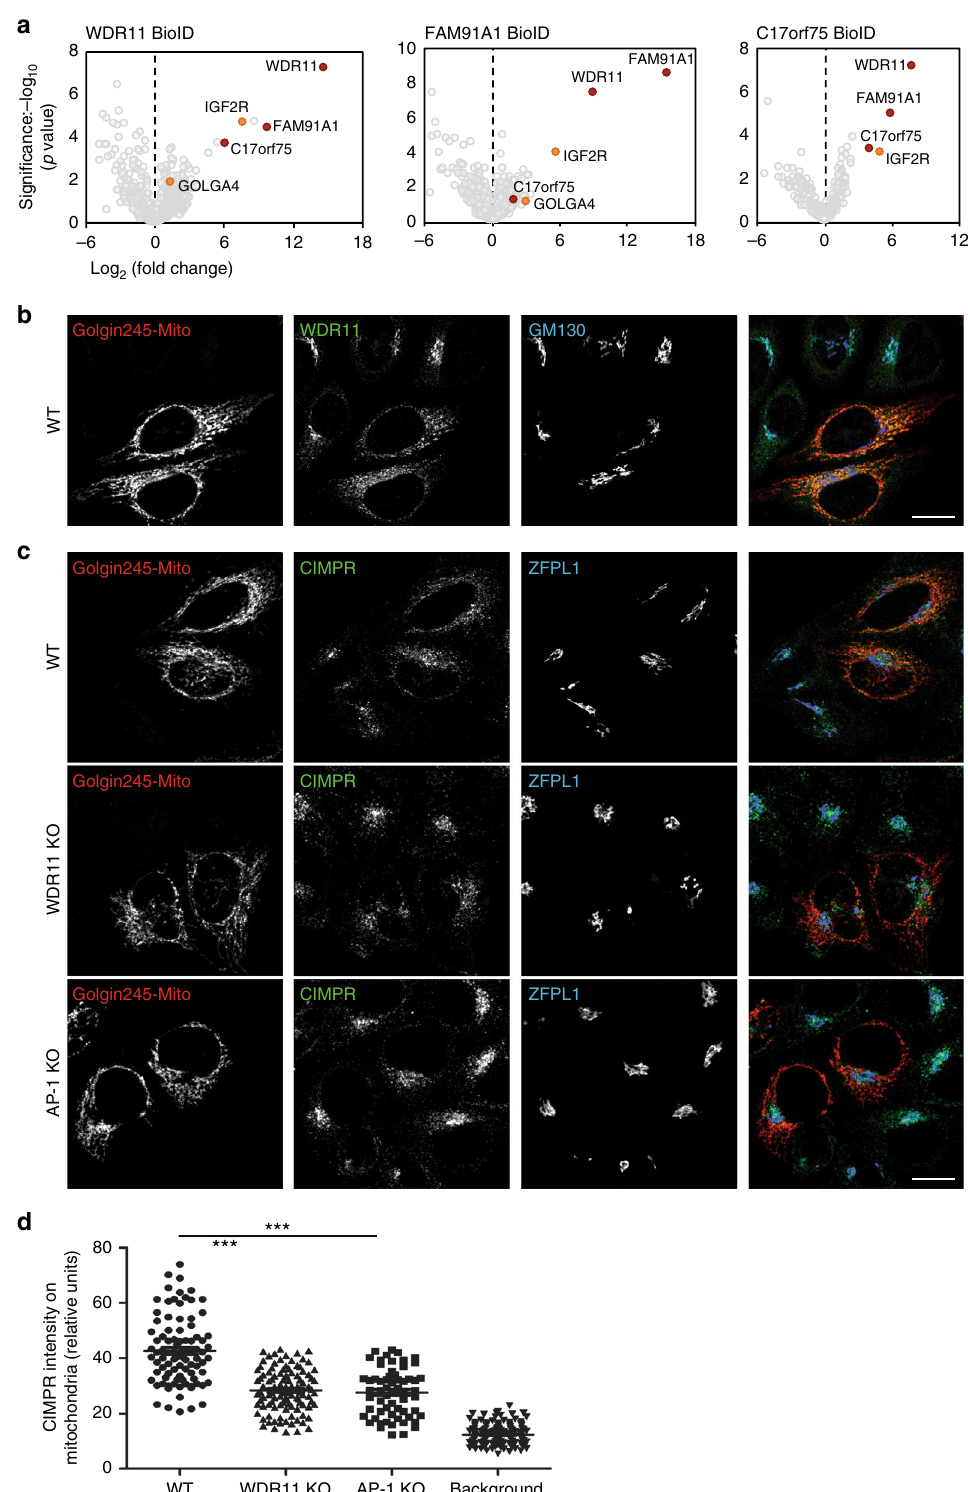
Fig. 6 Identi fi cation of additional interacting proteins by BioID. a BirA* was attached to WDR11, FAM91A1 or C17orf75, and biotinylated proteins were captured with streptavidin. Proteins predicted to be bona fi de binding partners are indicated on the volcano plots. IGF2R = CIMPR; GOLGA4 = golgin-245. b Golgin-245 was ectopically localised to the mitochondrial outer membrane (golgin-245-mito) and cells were triple labelled for WDR11 and the Golgi protein GM130. Expression of golgin-245-mito causes WDR11 to relocate to mitochondria. c Golgin-245 was ectopically localised to the mitochondrial outer membrane (golgin-245-mito) and cells were triple labelled for CIMPR and the Golgi protein ZFPL1. The ability of golgin-245-mito to relocate CIMPR- containing vesicles is markedly reduced in both WDR11- and AP-1-knockout cells. Scale bars: 20 µ m. d Quanti fi cation of mean CIMPR-labelling intensity within the mitochondrial segment (golgin-245) or elsewhere in the cell (background labelling). N ≥ 50 cells per cell line; three independent experiments; error bars: S.E.M.; one-way ANOVA and Bonferroni post hoc test; *** P ≤